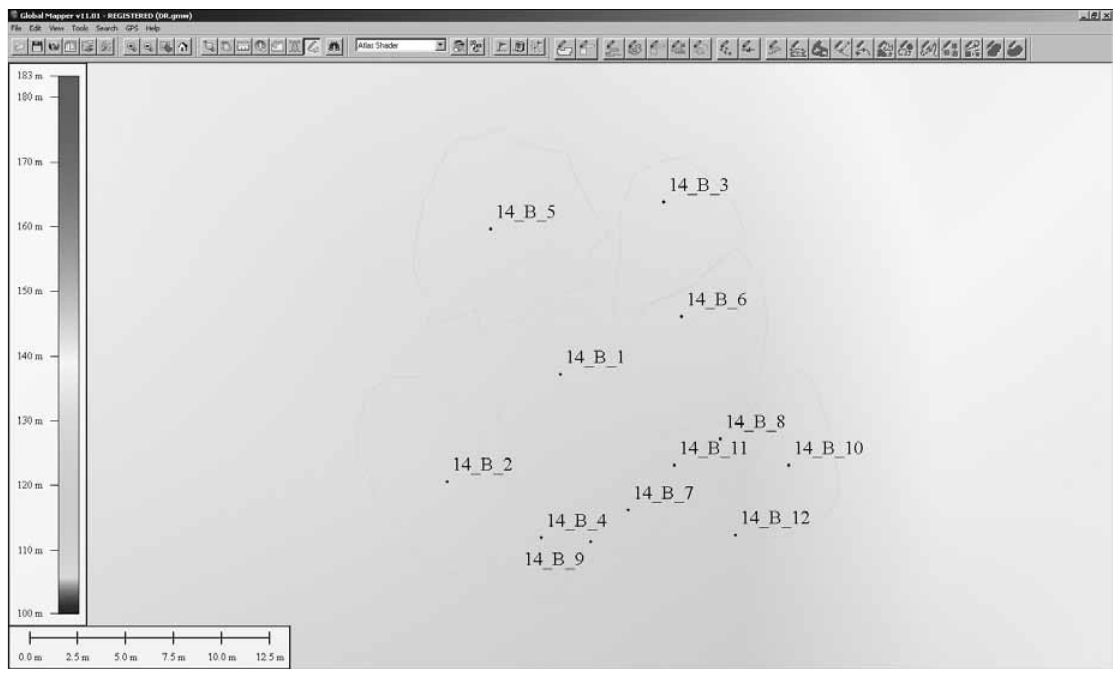
FIGURE 8 Objects collected in the StereoDraw module and loaded in the Global Mapper software for further processing